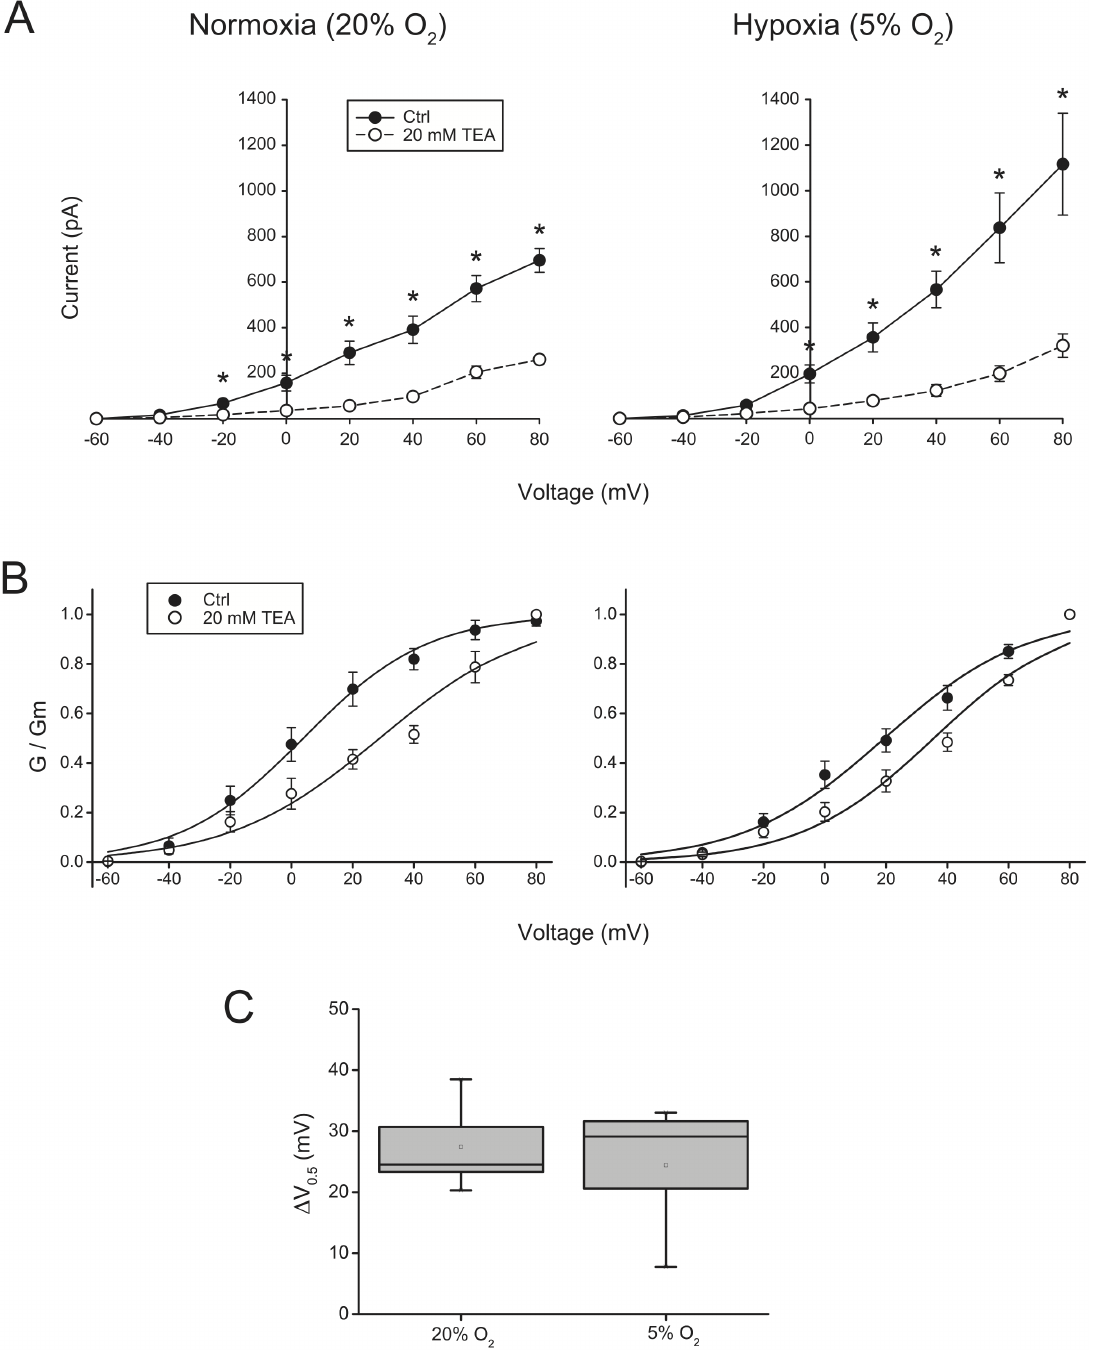
Figure 4. Inhibition of outward currents by TEA in ASCs cultured in normoxia and hypoxia. (A) Reduction in the steady-state current values as a result of 10 min perfusion with 20 mM TEA. Asterisks (*) denote a statistically significant difference (p , 0.05) between the control and TEA- treated cells (n=6). (B) TEA-mediated shift of the steady-state activation curves. The mean normalized conductance data was fitted using the Boltzmann sigmoid equation. (C) Boxplot (middle line: median; box: upper and lower quartile; bars: minimum and maximum values) of the change in V 0.5 after addition of TEA. No statistical significant differences were found (Mann-Whitney U test). doi:10.1371/journal.pone.0104912.g004 expected, TEA significantly inhibited the K + outward currents in hypoxia were both normoxia and hypoxia (n= 5, p , 0.05 in both conditions) 12.4 6 3.7 mV (n= 5, p , 0.05). However, comparison of these (Fig. 4.A). The activation kinetics curves were shifted by TEA, differences between the two groups did not produce statistically leading to significant differences in the voltage activation significant results (Fig. 4.C), indicating that hypoxia does not thresholds (Fig. 4.B). The values for D V 0.5 in normoxia and